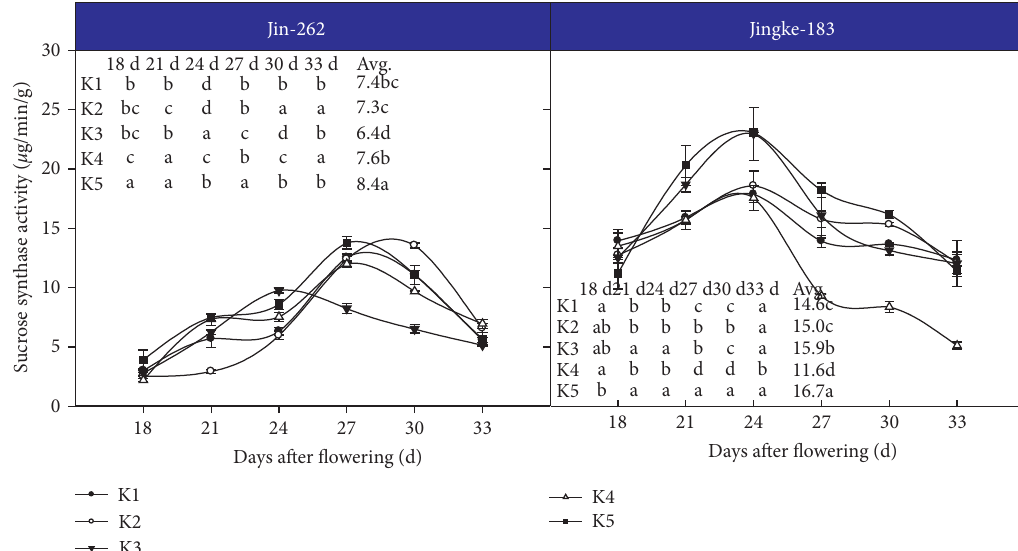
Figure 4: Effects of potassium on grain sucrose synthase activity of fresh-eaten maize kernel fresh weight. The different lowercase letters are significant differences at the 5% level; AVG, average; the bars are standard deviation ( n �